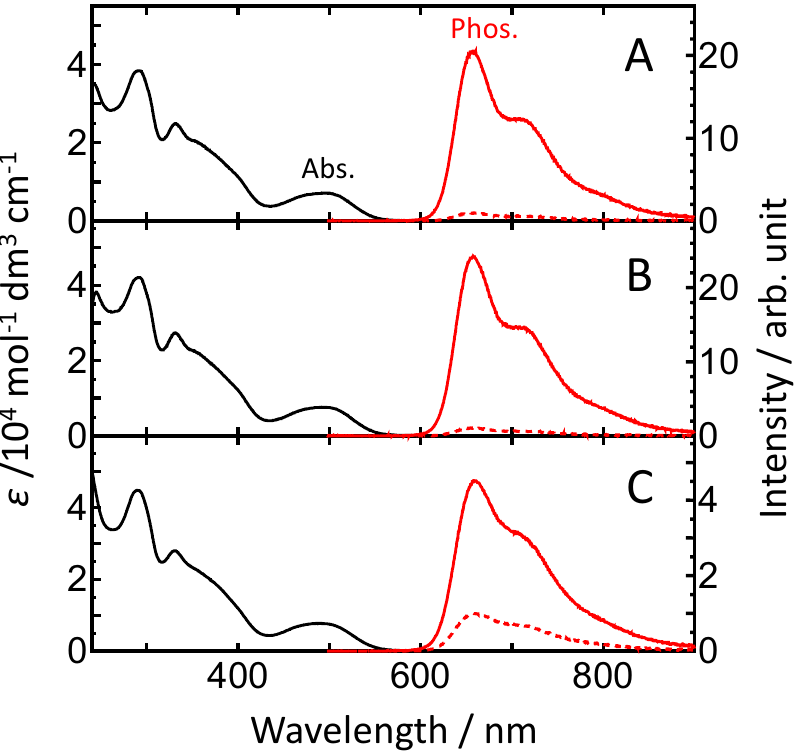
Figure 2. Absorption and phosphorescence spectra of BTQphen in MeCN ( A ), BTQ-R 12 in MeCN ( B ), and BTQ-R 12 in Tris–HCl buffer (pH 7.0) ( C ). These solvents contained 1% DMSO. ( A ) and ( B ) were measured at room temperature. Absorption spectra and phosphorescence spectra in ( C ) were measured at room temperature and 37 °C, respectively. The phosphorescence spectra were taken in both deaerated (solid line) and aerated (dashed line) solutions.